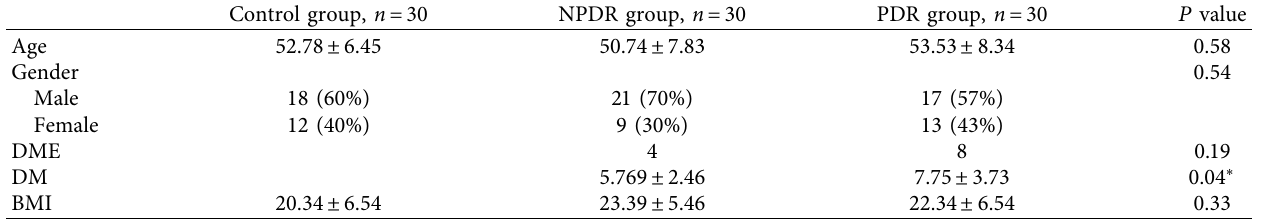
Table 1: Baseline characteristics of the